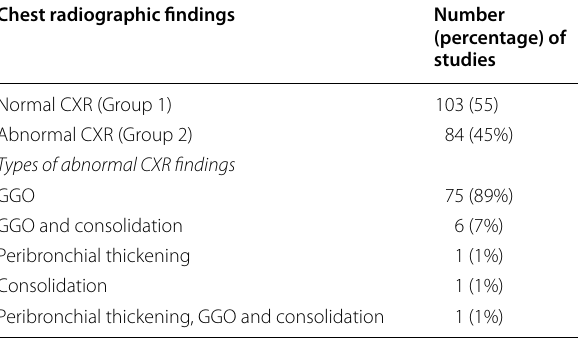
Table 1 Chest radiographic findings in 187 pediatric patients with COVID-19 pneumonia